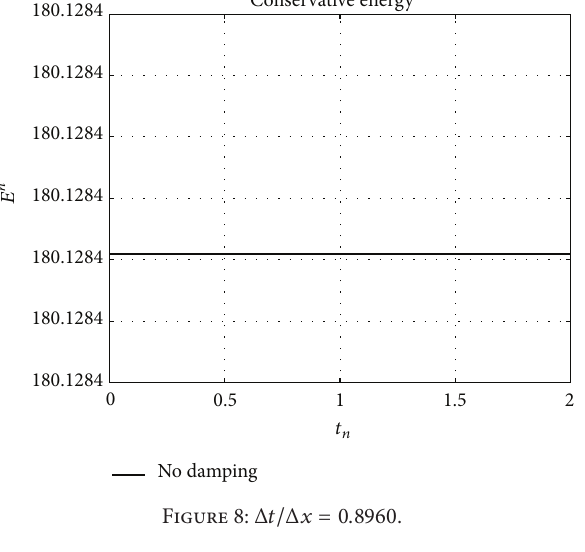
Figure 8: Δ𝑡/Δ𝑥 = 0.8960 .